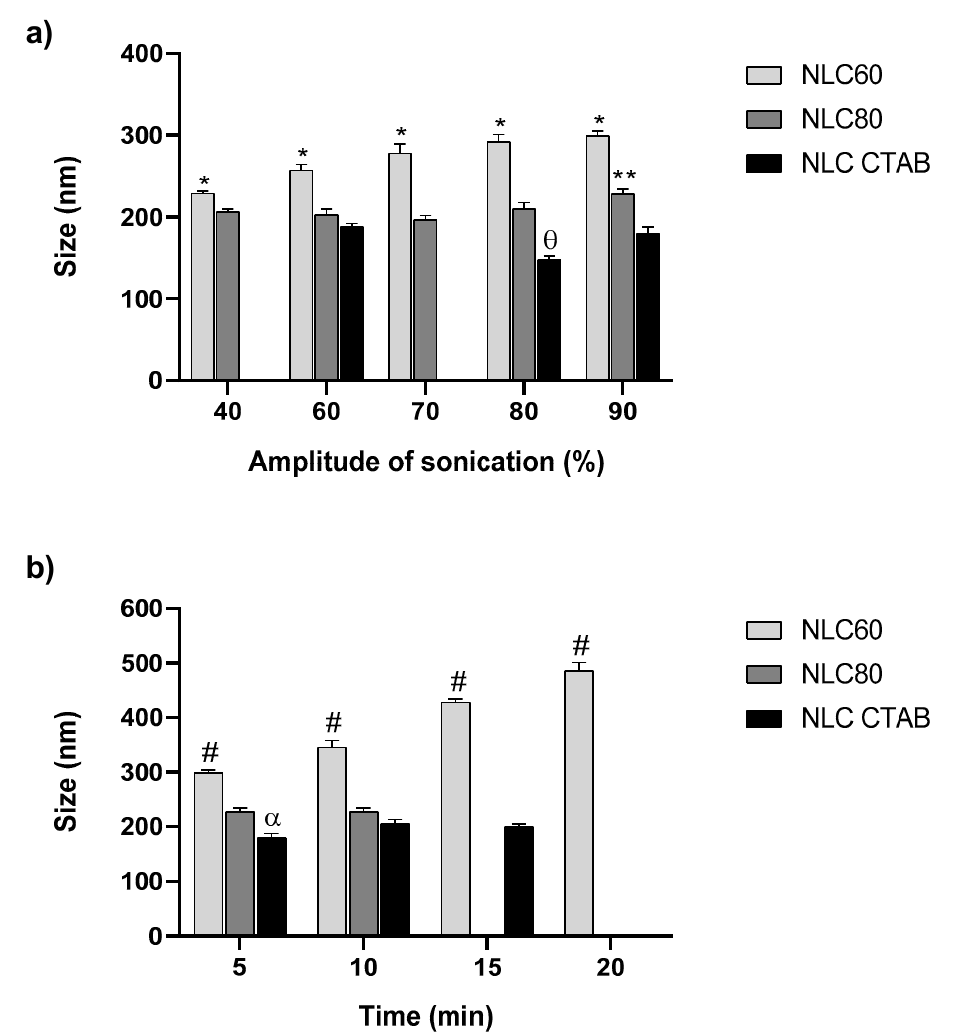
Figure 2. Effect of sonication parameters on NLC size (NLC60, NLC80 and NLC CTAB). ( a ) effect of changing the amplitude of sonication with fixed time (5 min); ( b ) effect of changing the sonication time at fixed amplitude (90%). Size distribution was measured by dynamic light scattering (DLS). Data are expressed as means ± standard deviation. In ( b ), only NLC60 were tested at 20 min, since no alterations were observed for NLC80 and NLC CTAB after 10 and 15 min, respectively. Statistical analysis was performed for each NLC formulation individually using Tukey’s multiple comparisons test. ( a ) * NLC60 size ( p < 0.05); ** NLC80 size ( p < 0.05); θ NLC CTAB size ( p < 0.0001); ( b ) # NLC60 size ( p < 0.0001) and α NLC CTAB size ( p <